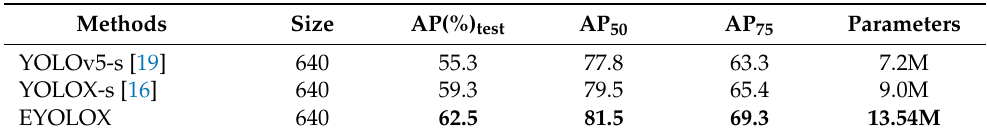
Table 5. Comparison of the accuracy of different object detectors on PASCAL VOC 07+12 test. Without the associated annotations, all our results are derived under 165